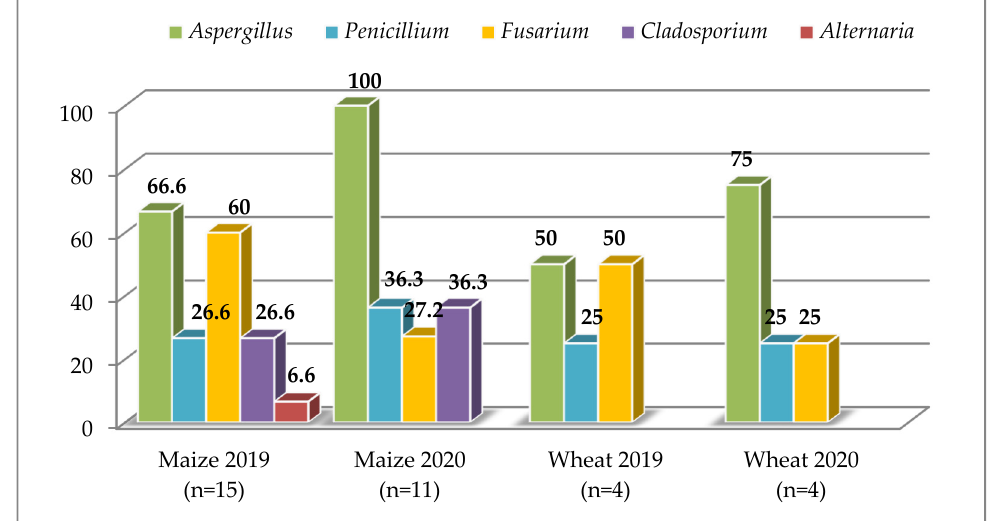
Figure 1. Proportion (%) of potentially toxigenic fungi genera in positive maize and wheat samples (n—number of positive samples).